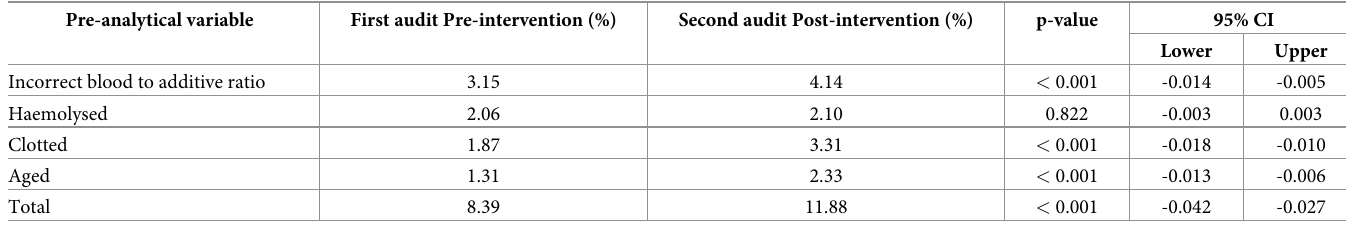
Table 2. Comparison of coagulation specimen rejection before and after training workshop intervention for each of the four principal pre-analytical variables. Pre-analytical variable